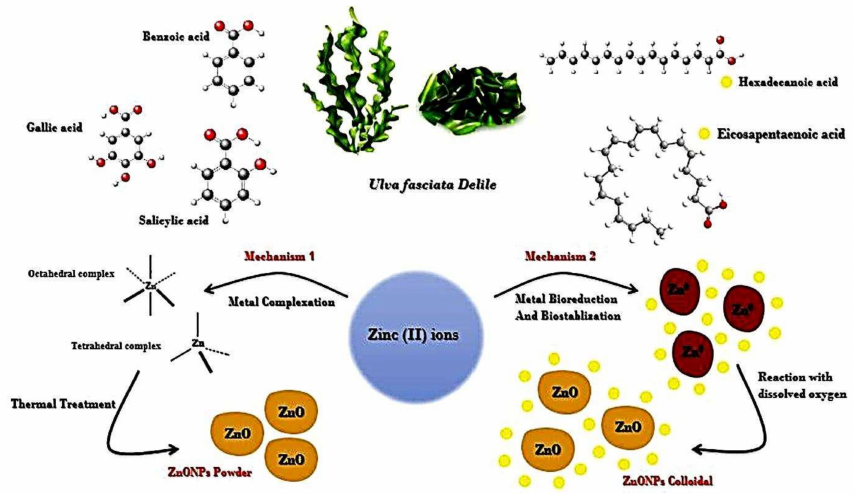
Figure 1. Possible mechanisms of ZnONPs phycosynthesis by Ulva fasciata Delile